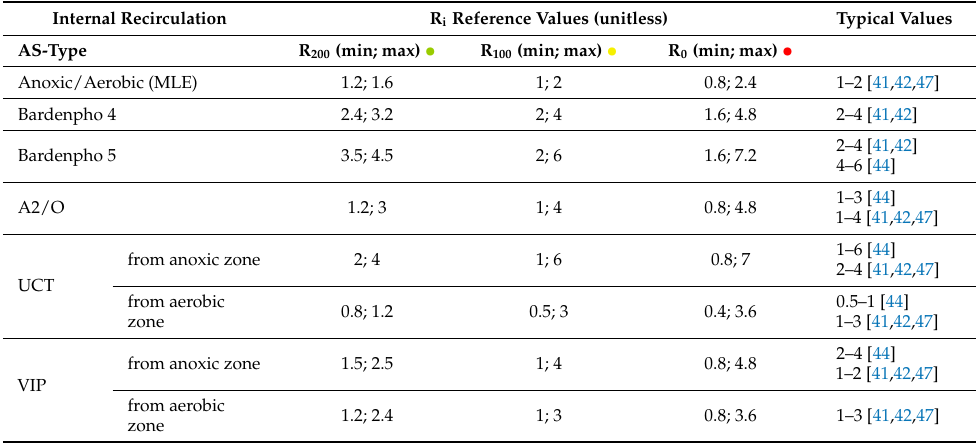
Table 9. The reference values for the internal recirculation in AS systems. Internal Recirculation